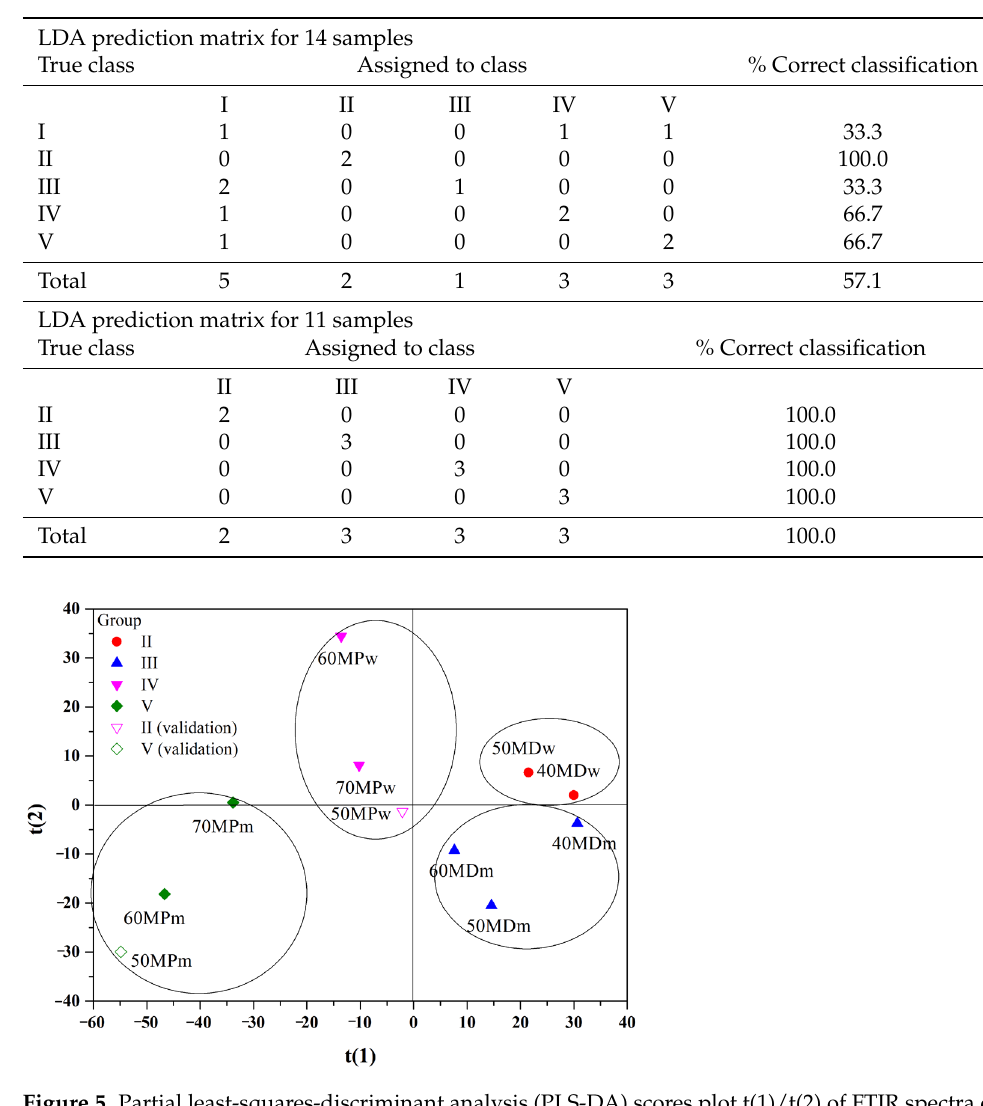
Table 5. Classification results of the classes computed by PLS-DA for training sample and validation sample.